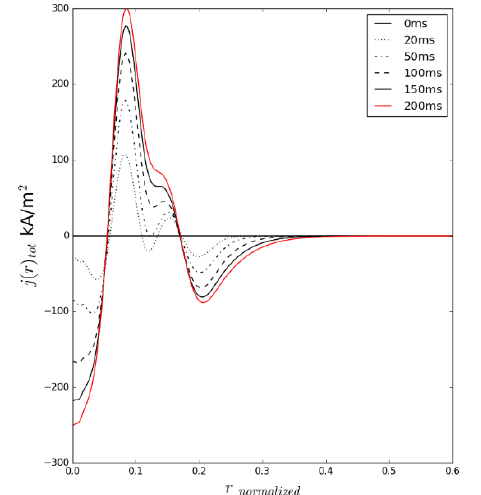
Figure 10: Sum of ECCD and shielding current at different time-steps. At t=0s, the two components compensate each other, therefore the resulting current is null. As the time increases, the shielding current diffuses and a net current arises.